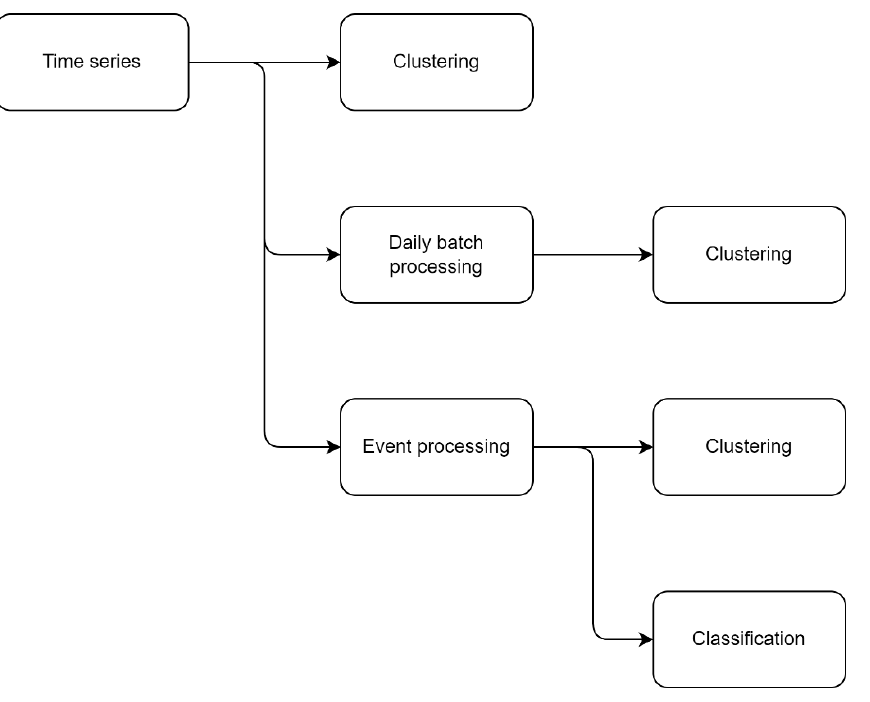
Figure 2. The processing